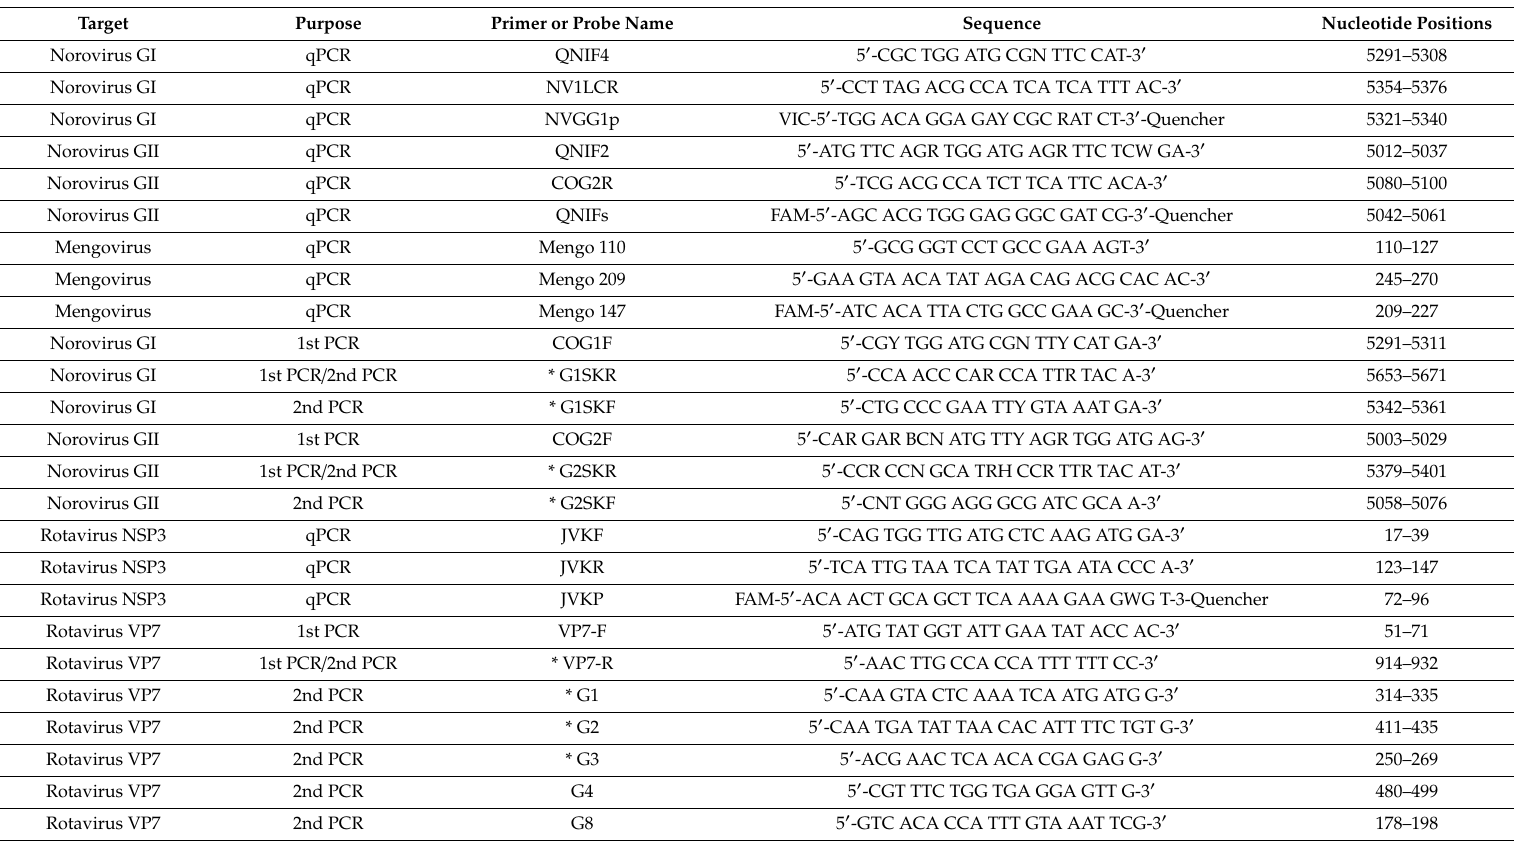
Table 1. Sequences of primers and probes utilized in the present study. The asterisk (*) indicate the names of the primers used for